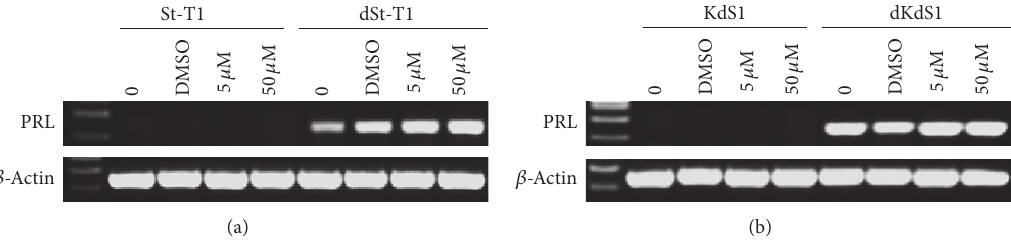
Figure 2: Representative qualitative PRL expression in St-T1 (a) and KdS1 (b) samples before and after decidualization (dSt-T1, dKdS1). Samples were treated only with IL-1 𝛽 (0), with IL-1 𝛽 and DMSO (DMSO) and with IL-1 𝛽 and MEK1/2 inhibitor (5 𝜇 M, 50 𝜇 M) as indicated. Expression of 𝛽 -actin served as housekeeping